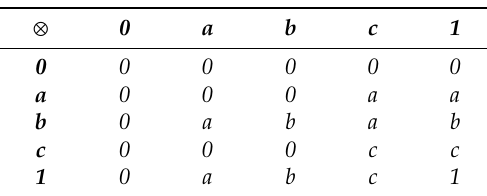
Table 1. The operation ⊗ on X .